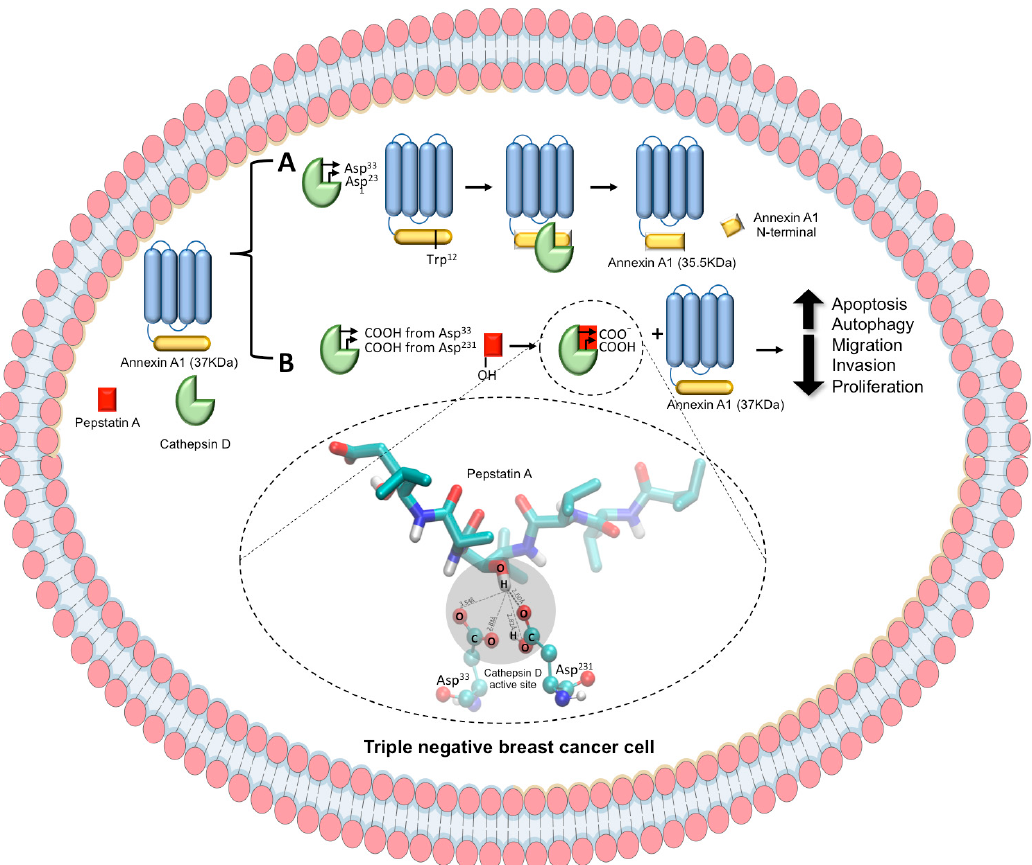
Figure 7. Schematic representation of CatD activity and inhibition by PepA and its in vitro consequences in TNBC cell. CatD is presented as a green generic representation, PepA, red square, and AnxA1 is presented as a core domain (blue) and an N-terminal domain (yellow). ( A ) On the one hand, CatD (with Asp 33 and Asp 231 from active site) cleaves AnxA1 at Trp 12 to yield 35.5 KDa fragment. ( B ) On the other hand, OH from PepA interacts with carboxylic acids from Asp 33 and Asp 231 from CatD active sites, blocking CatD protease activity. Then, AnxA1 remains intact (37 KDa), leading to a decrease of MDA-MB-231 aggressiveness, which includes increase of apoptosis and autophagy process and decrease of migration, invasion, and proliferation rates.